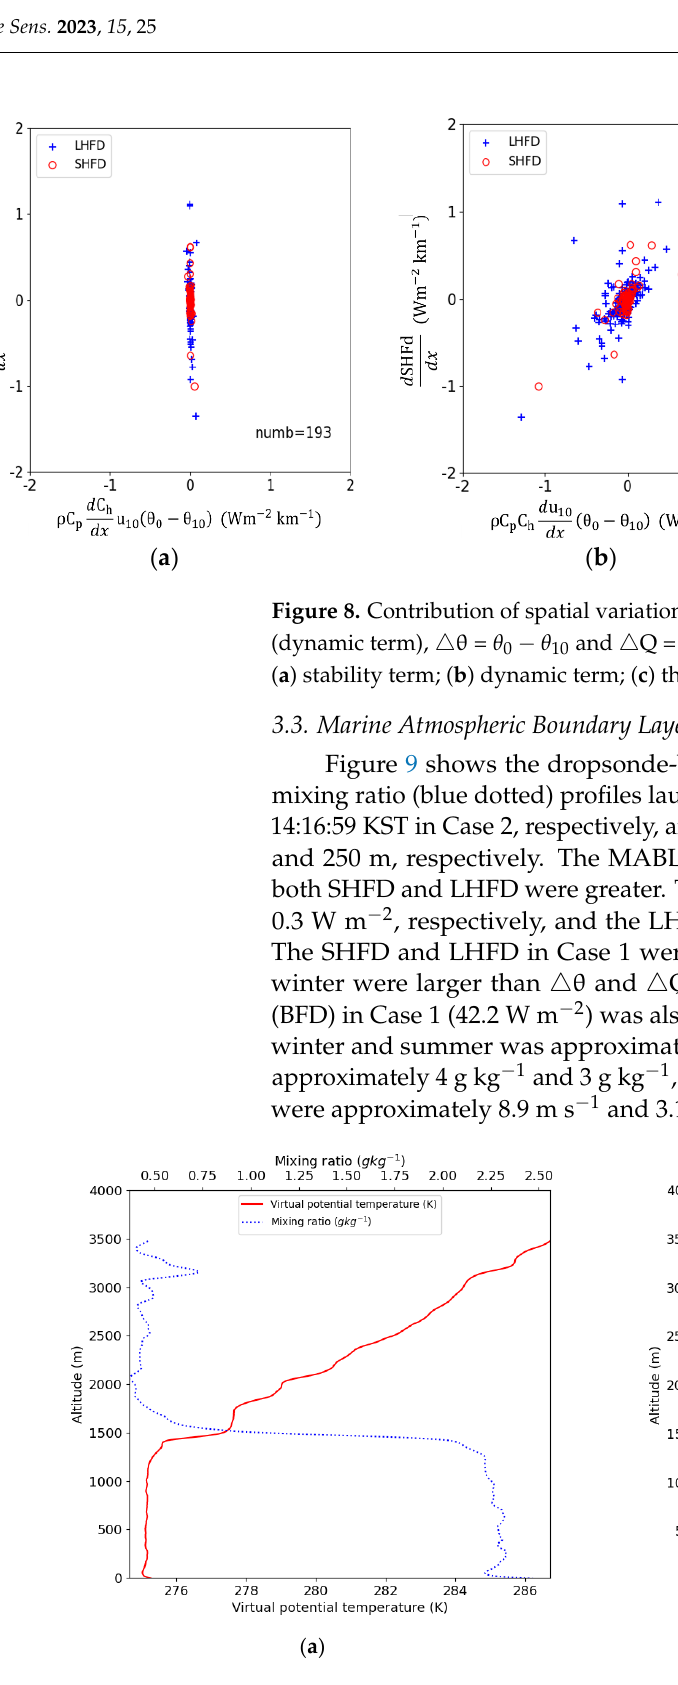
Figure 9. Dropsonde-based virtual potential temperature and mixing ratio profiles. The blue dotted and red solid lines represent mixing ratio and virtual potential temperature profiles. ( a ) 3 February 2021; ( b ) 2 August 2021.